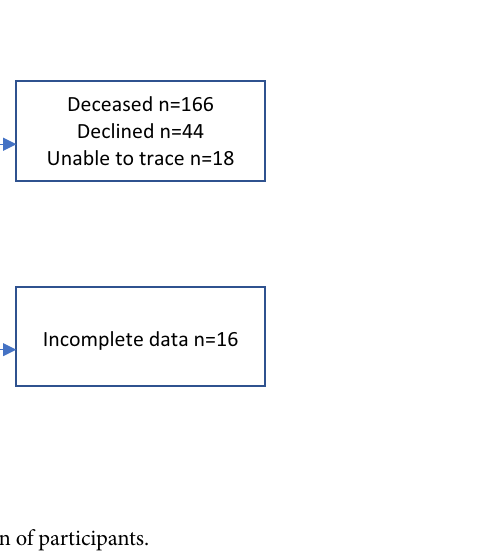
Figure 1. Flow diagram of inclusion of